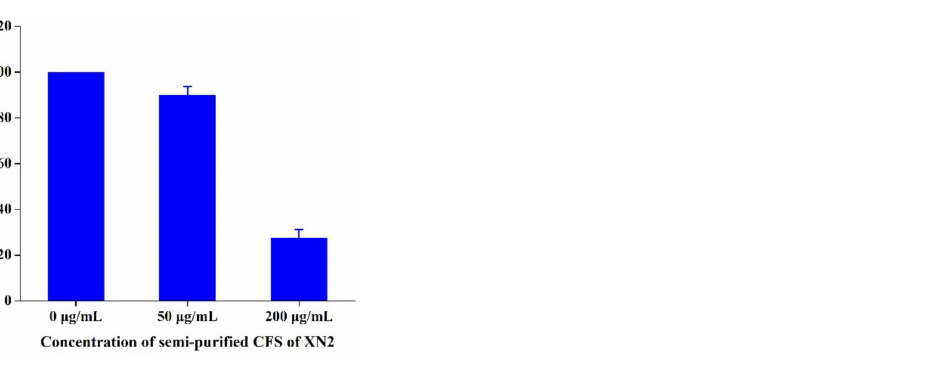
Figure 4. Effects of semi-purified CFS of strain XN2 on the secretion of α -haemolysin by S. aureus . The data are shown as mean ± standard deviation. The critical limit is 5%. p < 0.05, the differences are significant.